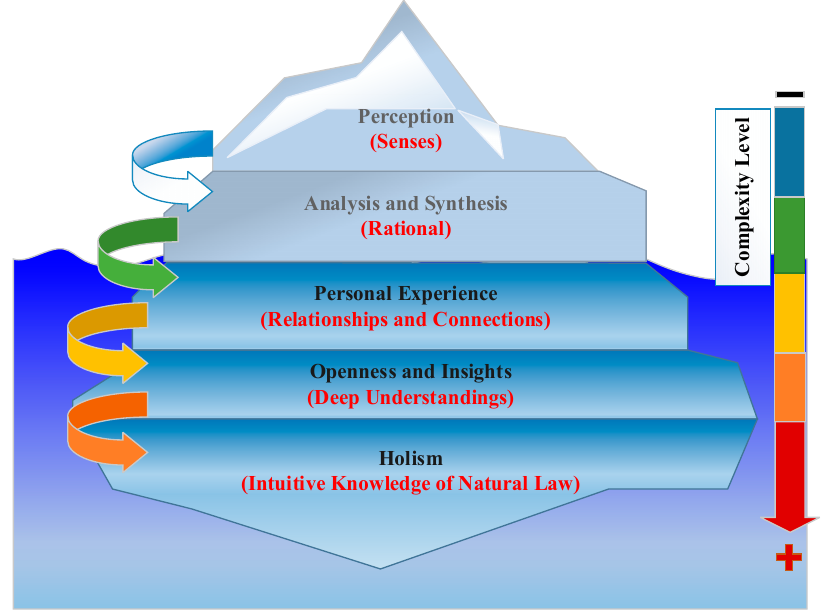
Figure 1. The Iceberg model of decision-making and